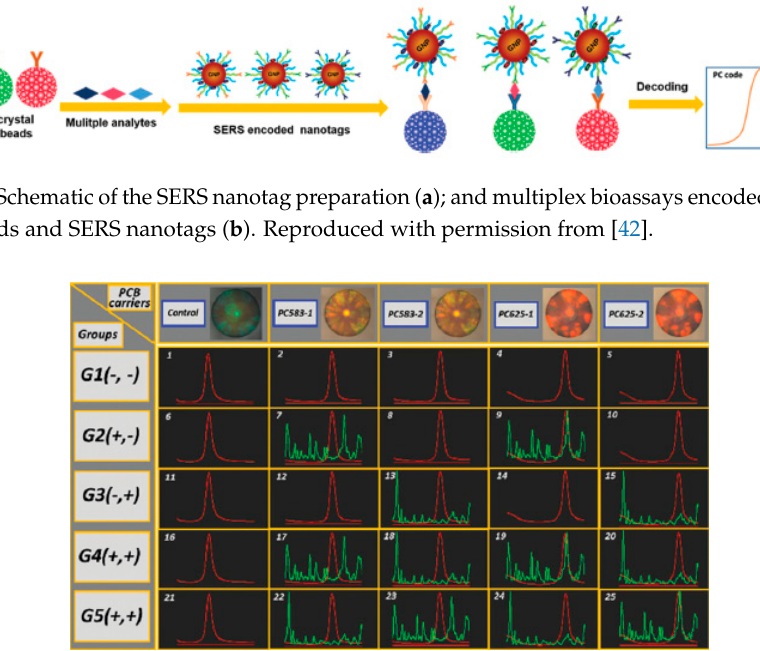
Figure 17. Multiplexed assays for qualitative detection of mouse IgG and rabbit IgG. In the top row are the microscopy images of three silica PCBs modified with different Fab fragments. In the middle rows are the results of multiplexed assays (red lines are reflection spectra of silica PCBs, and green lines are Raman spectra of SERS nanotags). Reproduced with permission from [42].